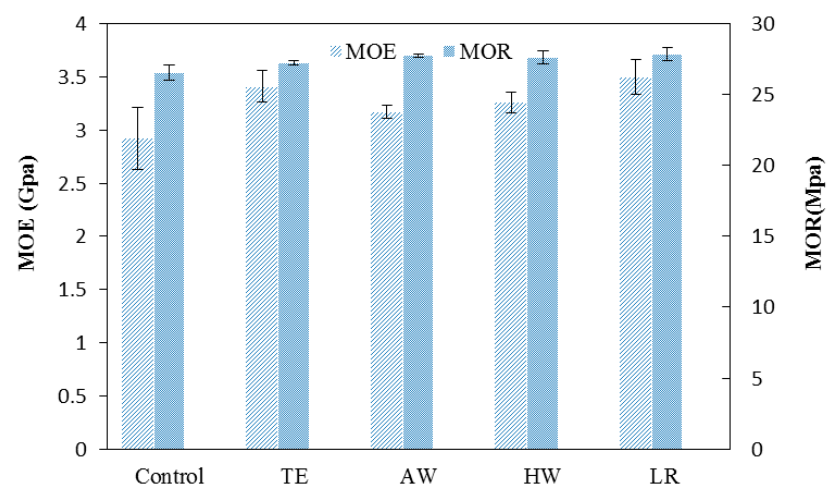
Figure 5. The MOE and MOR of the WPCs reinforced with extracted or delignified WF.